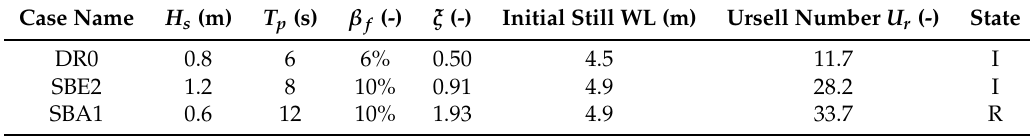
Table 1. Three beach state cases (I: intermediate, R: reflective). WL: water